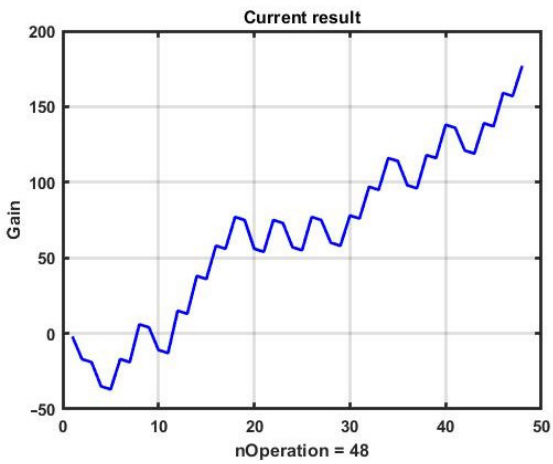
Figure 9. Effectiveness of the CSF strategy with evolutionary optimization.